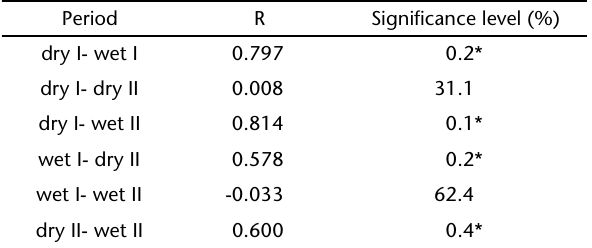
Table I. One-way ANOSIM results showing significant differences (*) in environmental variables between sampling periods in Saquarema-Jaconé lagoonal